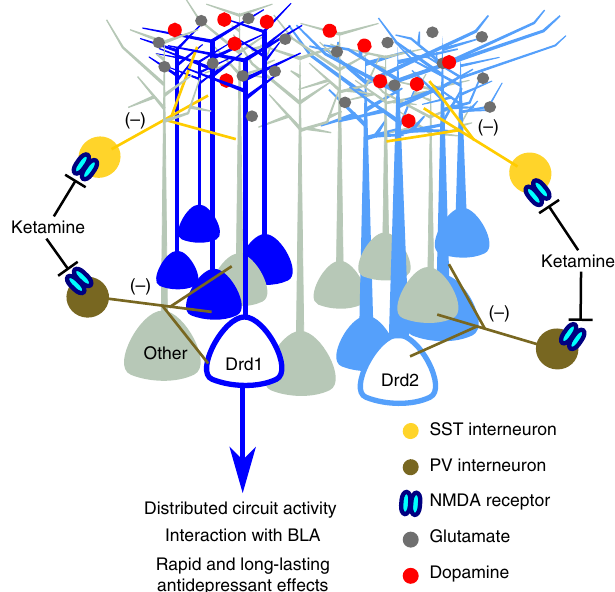
Fig. 8 Proposed model of ketamine associated activity at Drd1 cells in the mPFC. Antagonism of NMDA receptors on GABAergic interneurons produces a non-speci fi c glutamate burst. Activation of Drd1 expressing pyramidal cells modulates activity in output structures. mPFC Drd1 cell projections to the BLA play a role in the antidepressant response to photostimulation and ketamine, but are likely not the only downstream targets of mPFC activation. Drd1 cell activity concurrent with D1r activation results in rapid and long-lasting antidepressant effects. SST somatostatin, PV